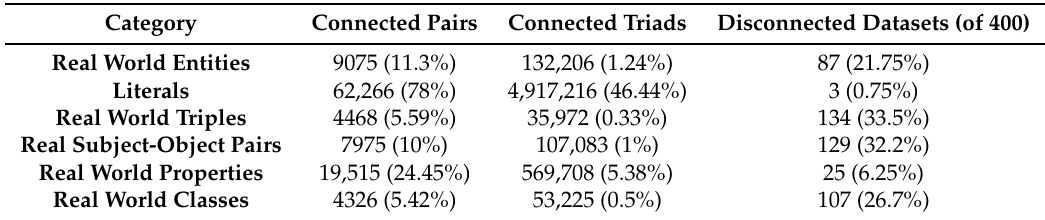
Table 10. Connected subsets of datasets.